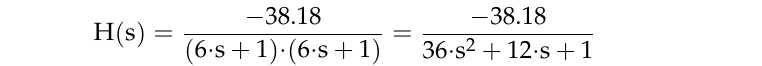
Figure 7. Comparison between the two types of proposed models. From Figure 7, it follows that the proposed Gaussian mathematical model ensures a higher accuracy than the mathematical model of the second order, the related response being closer to the dynamics of the experimental response. Another important problem is represented by the need for mathematical modeling of the intensity of the electric current I R (t) associated with phase R. The dynamics of the I R (t) signal, obtained experimentally, are presented in Figure 8.